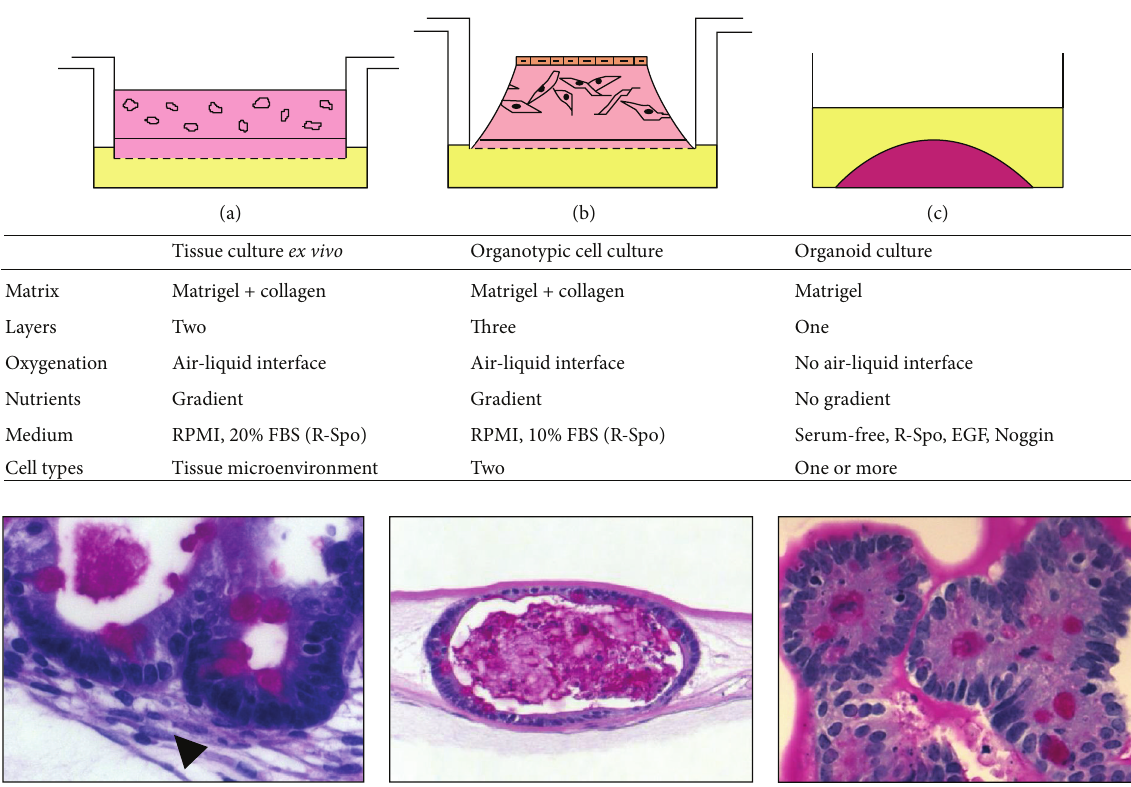
Figure 1: Summary of three-dimensional methods to culture intestinal epithelium. (a) Tissue culture ex vivo . Arrowhead indicates stromal cells. (b) Organotypic cell culture. (c) Organoid culture. PAS staining. R-Spo,